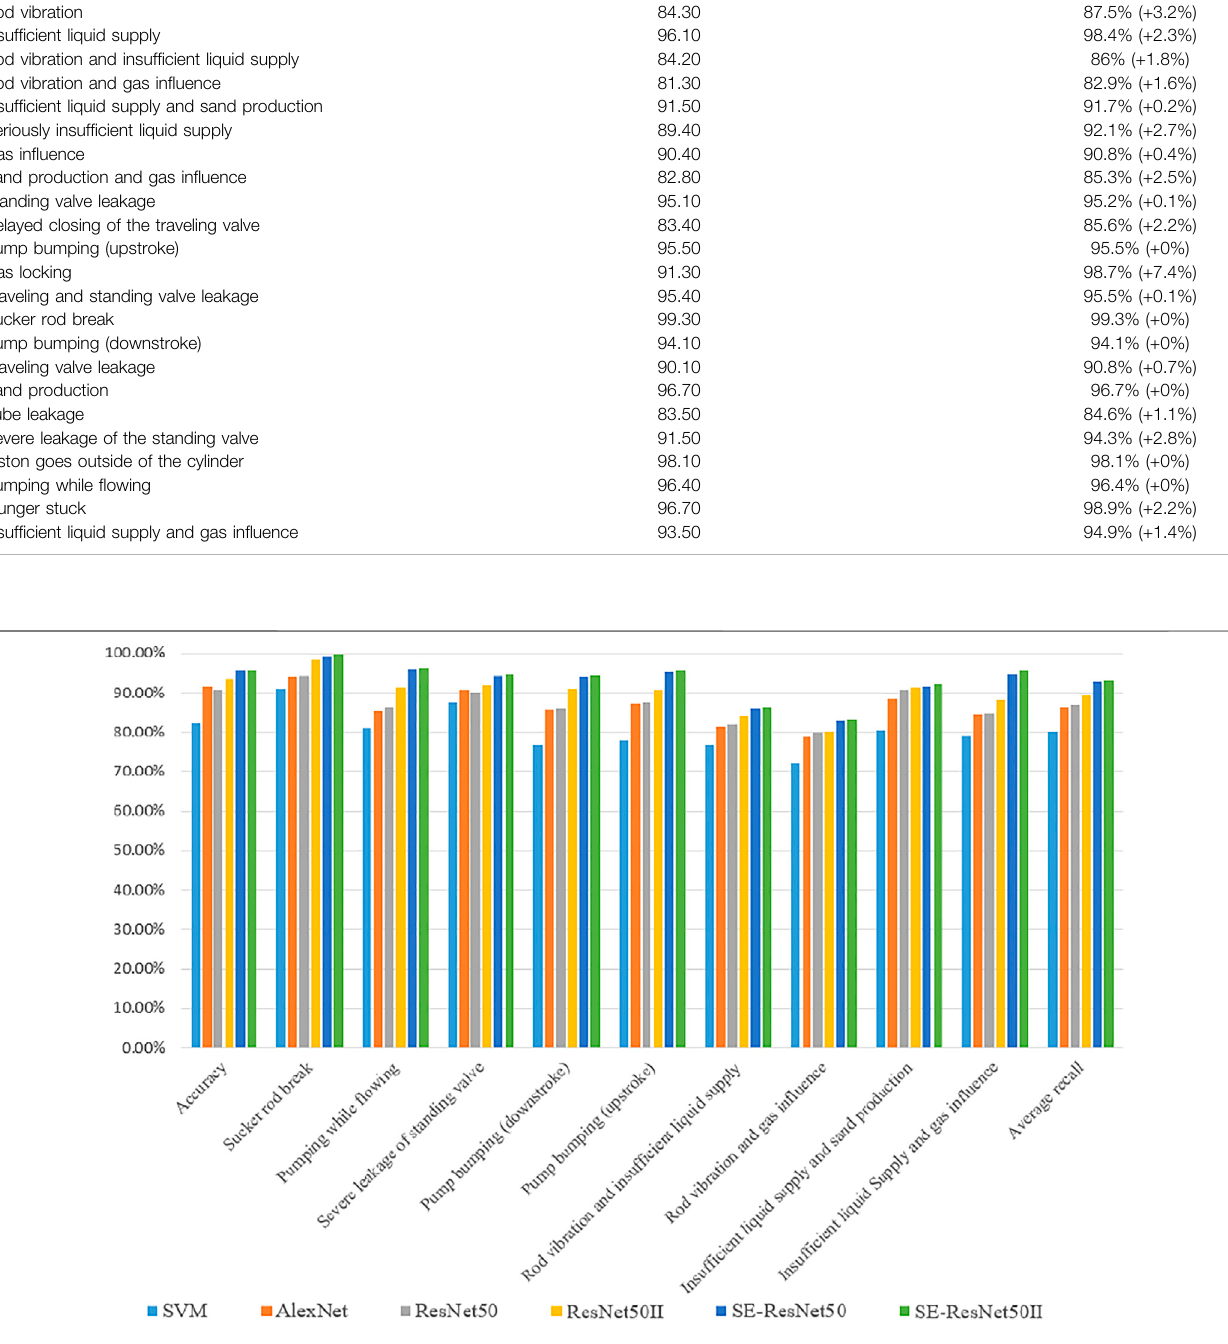
Frontiers in Earth Science |